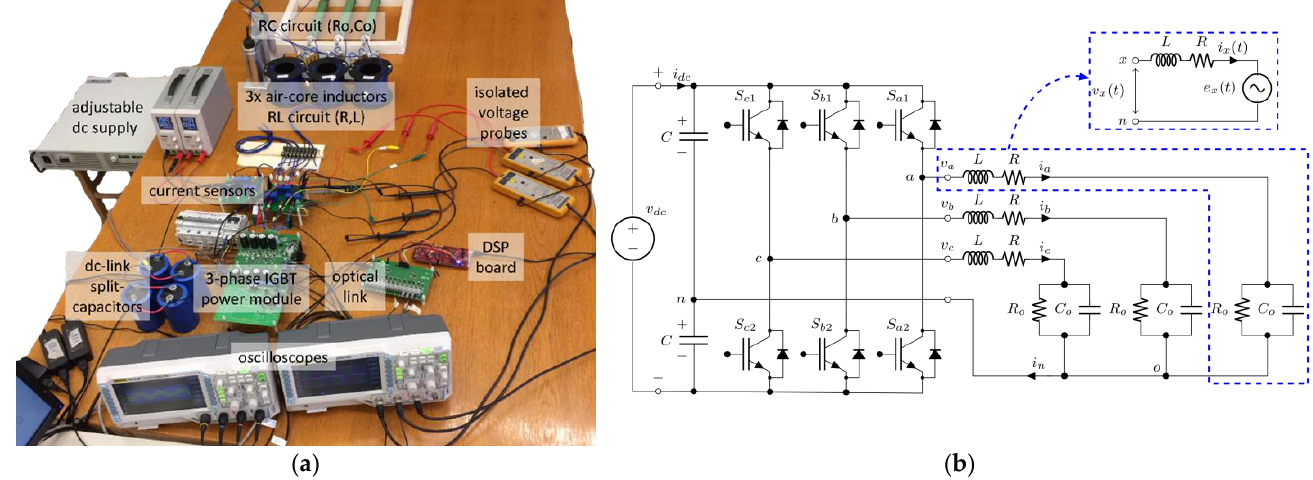
Figure 12. ( a ) View of the laboratory test bench together with the devices used for control and acquisition. ( b ) Unity power factor three-phase load connected to the four-wire split-capacitor converter emulating V2G operations.